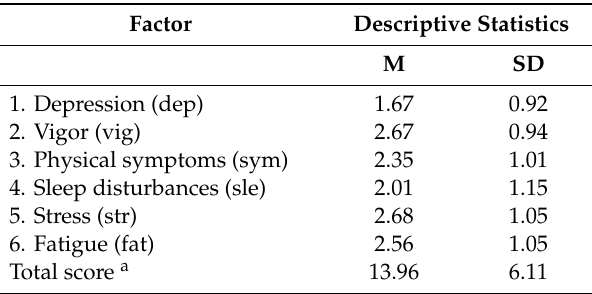
Table 9. Mean scale scores for the six factors in